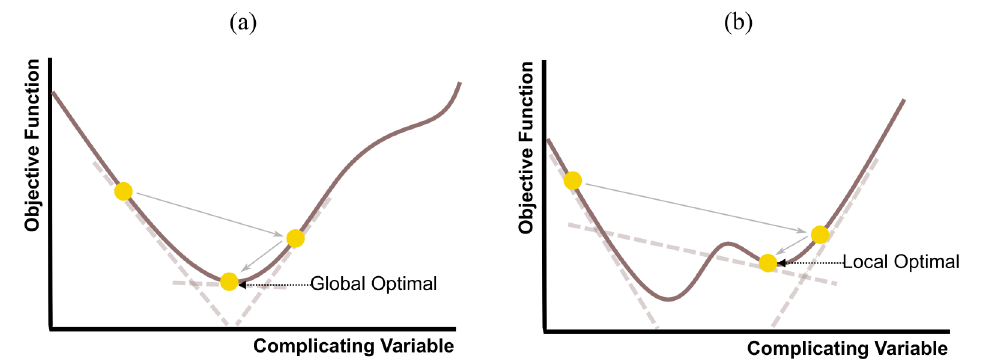
Figure 8. The conversion steps of the complicated variable when it is Convex ( a ) and Non-Convex ( b ) with respect to the objective